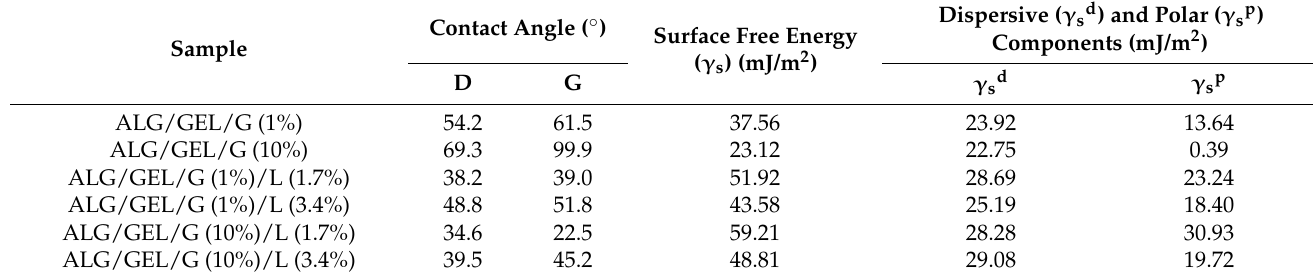
Table 2. The contact angles ( ◦ ) of diiodomethane (D) and glycerol (G), the surface free energy ( γ s ), dispersive ( γ sd ) and polar ( γ sp ) components for polymer films based on sodium alginate, gelatin, and glycerol with the addition of lipids (calculated by Owens–Wendt